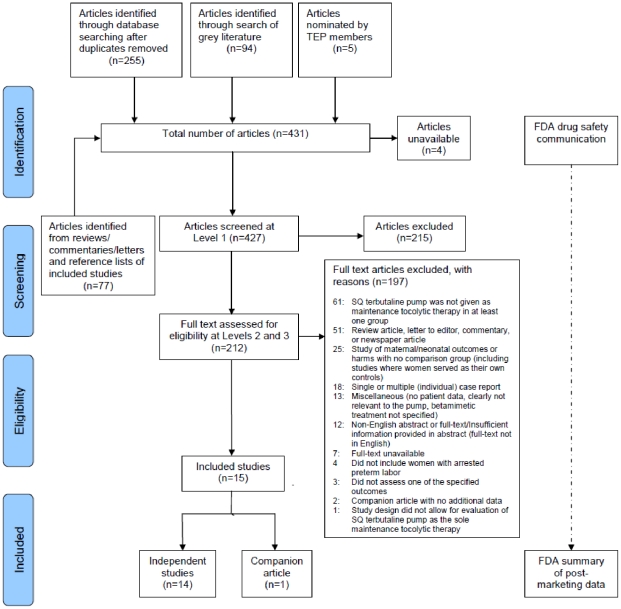
Flow of retrieved records through screening and inclusion.